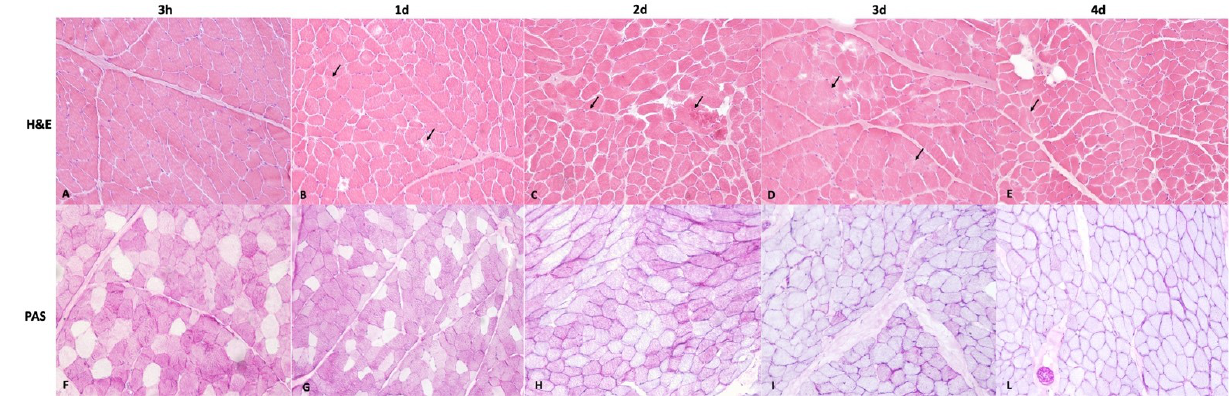
Figure 1. Representative sections from muscle tissues at different times since death. (A) Section from muscles taken at 3 hpm (Group 192 A) showing no microscopical changes; (B) section from muscle taken at 1 day postmortem (Group B) showing focal areas of autolysis 193 (arrows). C-D-E : Section from muscles taken at 2, 3 and 4 days postmortem (Groups C-D-E), respectively. Sections showing only 194 small focal or multifocal areas of autolysis (arrows) (H&E, original magnification 20x). (F) Section from muscles taken at 3-hpm 195 (Group A) showing strong PAS-positive fibers; (G) section from muscle taken at 1 day (Group B) postmortem showing PAS-positive 196 fibers. (H) Section from muscles taken at 2 days (Group C) postmortem showing a moderate number of PAS-positive fibers. (I) section 197 from muscles taken 3 days (Group D) postmortem showing a low number of mildly PAS-positive fibers. (L) Section from muscles 198 taken 4 days postmortem (Group E) showing no PAS-positive fibers. (Periodic acid shiff (PAS) staining, original magnification 20x). 199